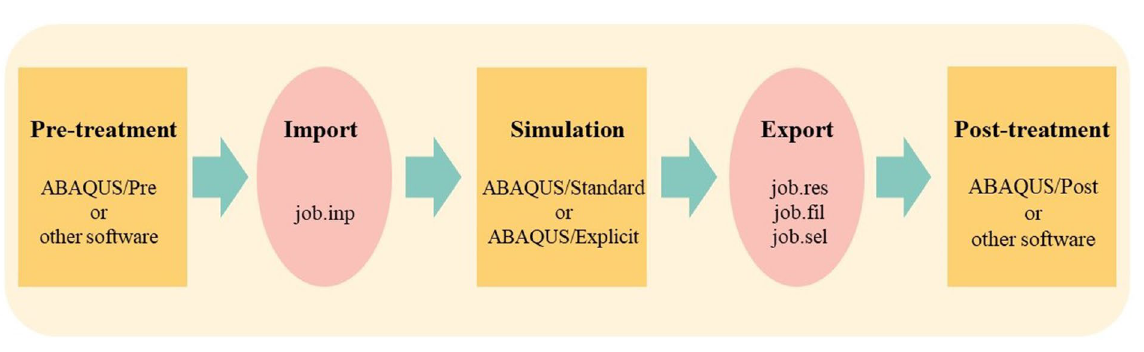
Figure 4. Analysis process of